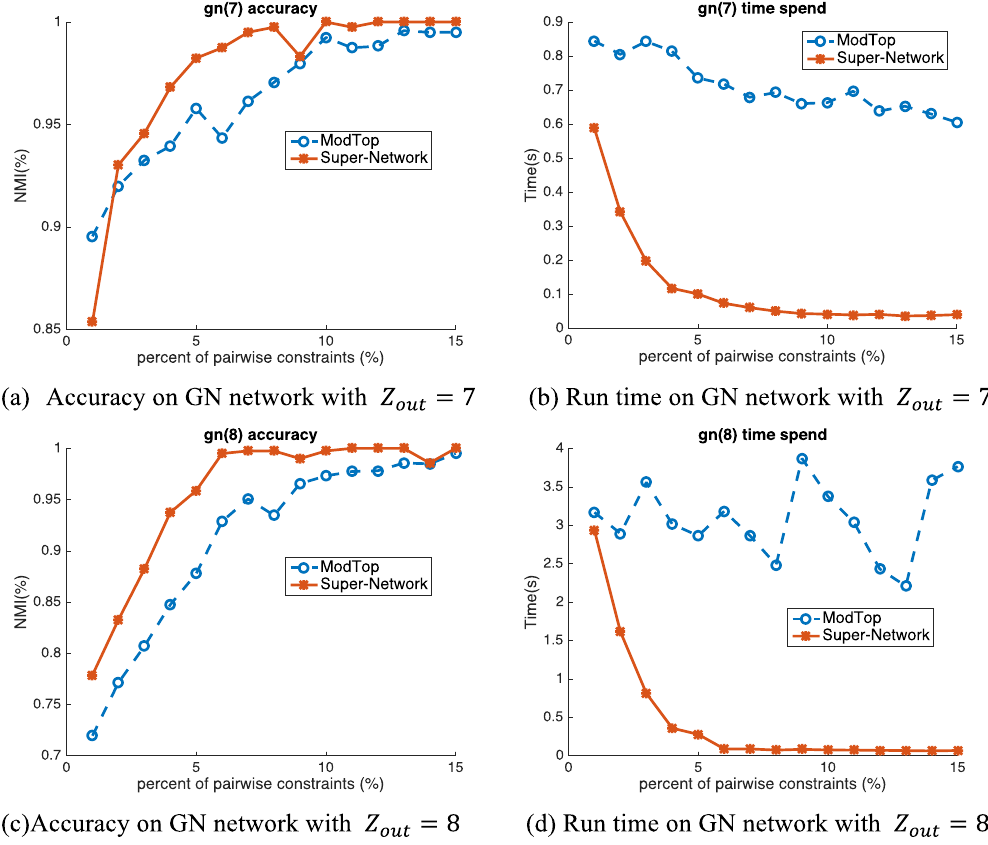
Figure 3. Accuracy (NMI) and run time (spent time in second) on GN benchmark networks based on